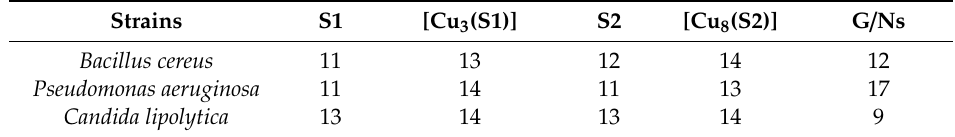
Table 2. Zones of inhibition (in mm) of the model strains by the investigated compounds. Gentamicin (G) and nystatin (Ns) used as a standard antibacterial and antifungal agent, respectively. Strains S1 Bacillus cereus Pseudomonas aeruginosa